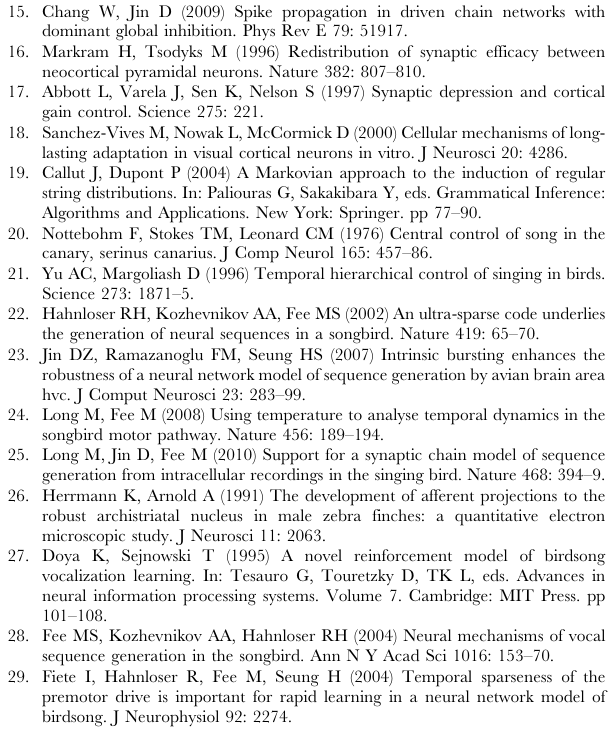
repeat (left), the N-gram (middle) and the step probability (right) distributions. a. Bird 1. b. Bird 2. The POMM’s are shown in Fig. S2 and S3. The gray bars are the bench marks. Figure S5 The hidden Markov model (Bird 1). The HMM with 18 states are shown. In each state, the syllable with the maximum emission probability is shown, along with the maximum emission probability. Other conventions are the same as in Fig. 2. Figure S6 The hidden Markov model (Bird 2). The HMM with 18 states are shown. In each state, the syllable with the maximum emission probability is shown, along with the maximum probability. Other conventions are the same as in Fig. 2. Figure S7 Summary of the differences between sequences generated with the hidden Markov models and the observed sequences for the repeat (left), the N-gram (middle) and the step probability (right) distributions. Number of states in the models are indicated with the colors: cyan, 8; green 13; red, 18; and black, 23. a. Bird 1. b. Bird 2. Found at: doi:10.1371/journal.pcbi.1001108.s007 (0.38 MB